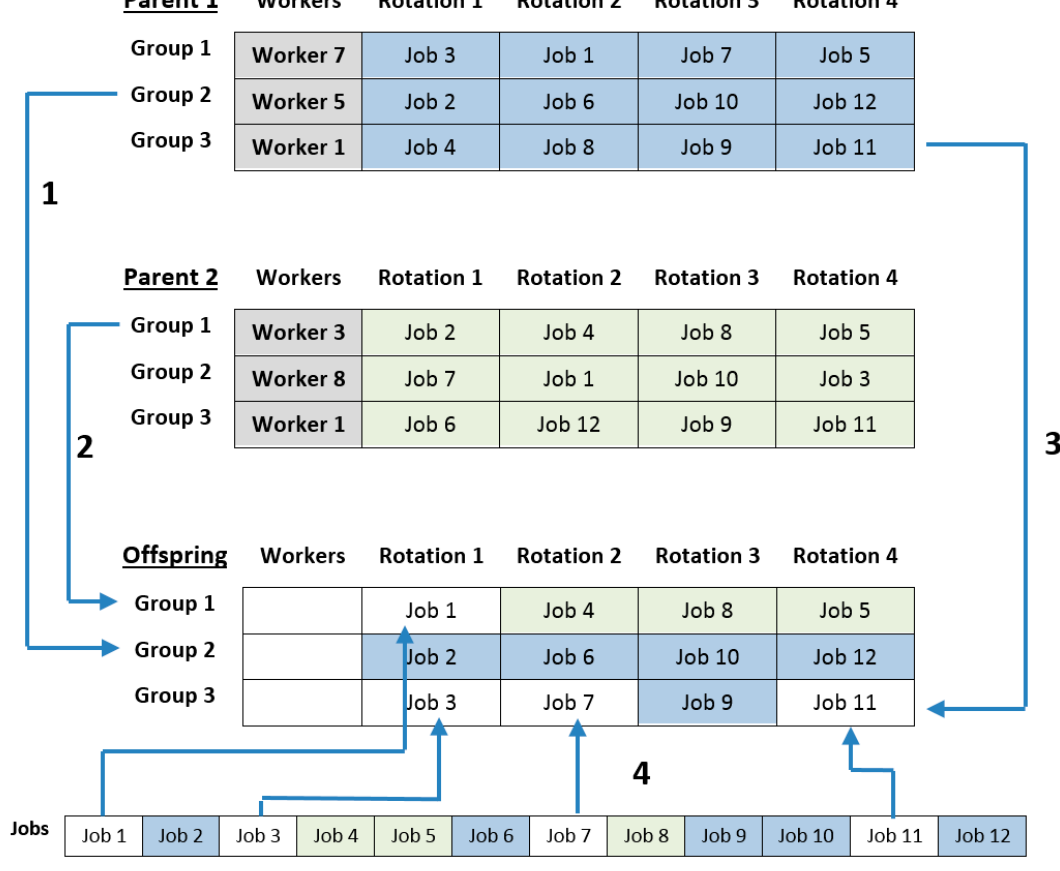
Figure 4. Example of generation of o ff spring through crossover of two parents. The numbers 1 to 4 represent the sequence followed to generate the o ff